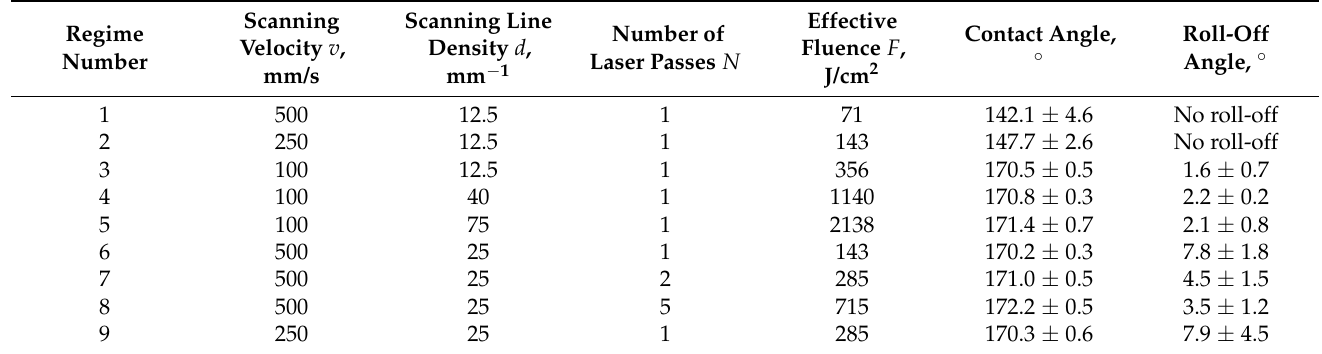
Table 1. The parameters of laser texturing and wettability characteristics of the obtained